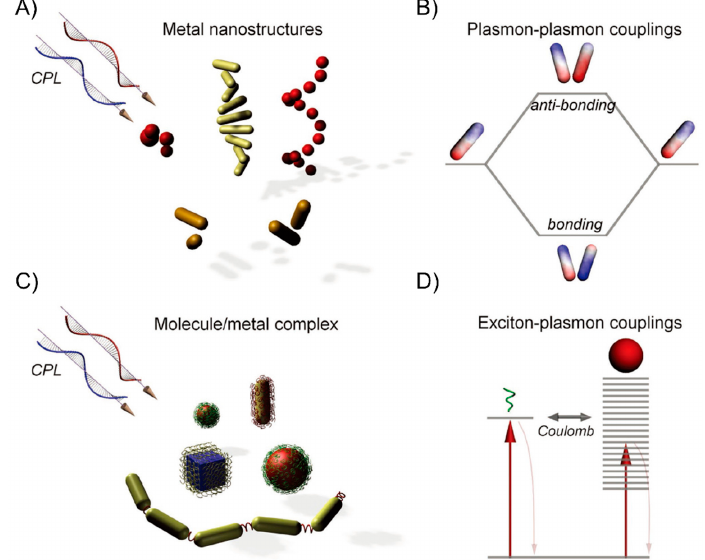
Figure 5. The representative physical principles involved in the chiral plasmonic nanostructures under circularly polarized light (CPL): plasmon–plasmon coupling ( A , B ) and exciton–plasmon coupling ( C , D ). Reproduced with permission from Reference [69]. Copyright John Wiley & Sons, Inc., 2016.